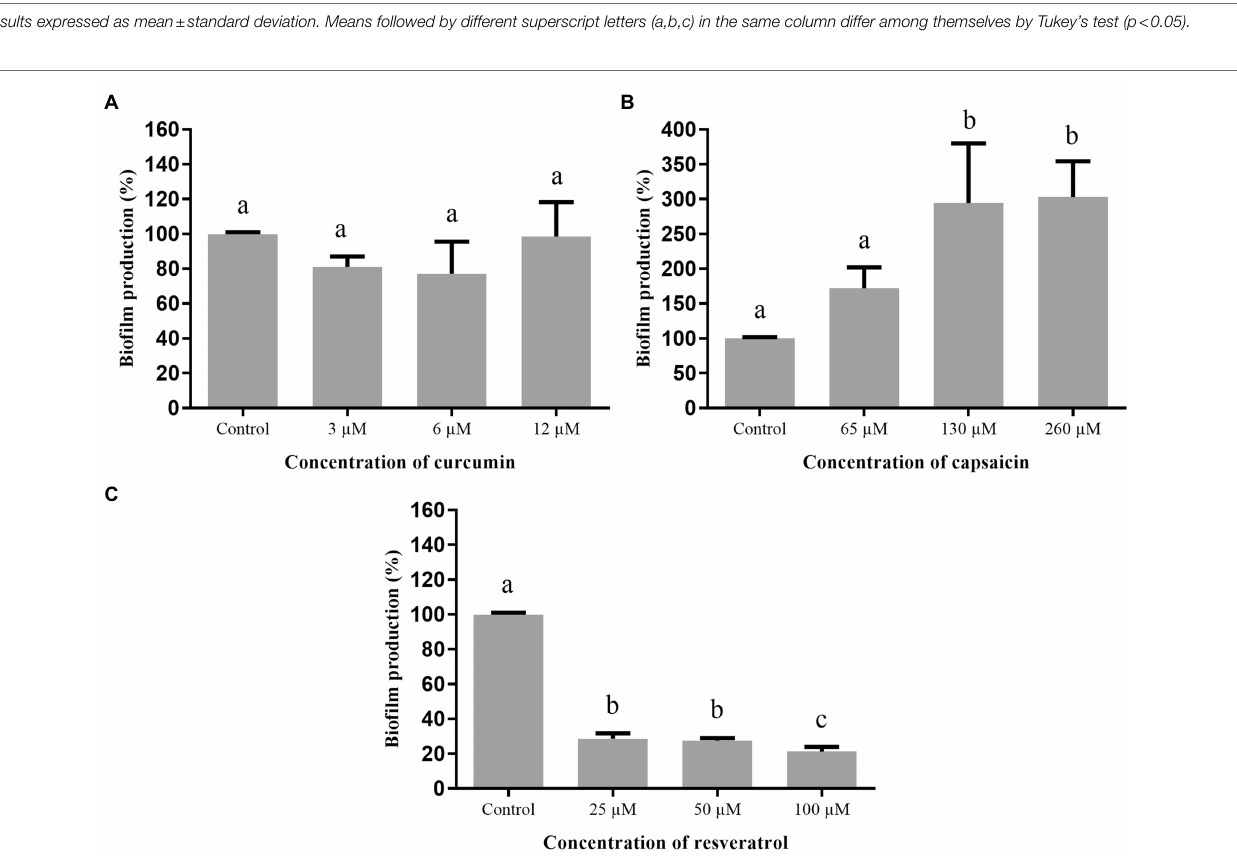
FIGURE 4 | Effect of phenolic compounds on biofilm formation by Aeromonas hydrophila IOC/FDA 110-36, expressed as percentage of production, when compared to the control (100%). curcumin (A) ; capsaicin (B) ; resveratrol (C) ; and control = biofilm formation in LB broth + DMSO (1%). Means followed by different letters differ among themselves by Tukey’s test ( p <